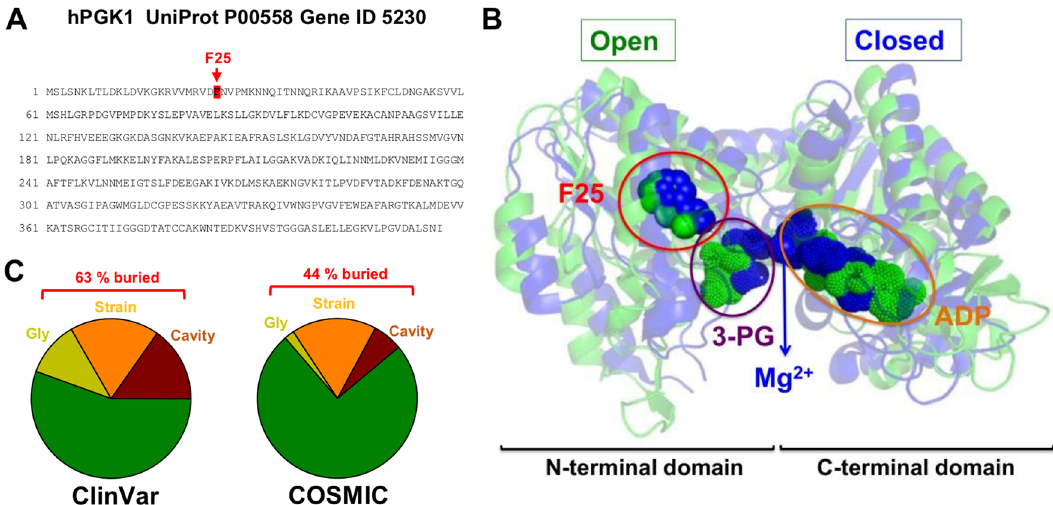
Figure 1. Location of F25 in the sequence and structure of hPGK1 and the biological significance of the mutations analyzed in this study. ( A ) Sequence of the hPGK1 protein (UniProt and Gene ID are indicated). The position of F25 is highlighted. ( B ) Structural location of F25 in two different conformations (open and closed) of hPGK1. The open conformation (PDB code 2XE7) is shown in green and closed conformation (PDB code 2X13) is shown in blue. These structures were reported in 14 . The location of 3-PG, ADP and Mg 2+ is also indicated as well the two domains of the protein. Please note that the conformational transition from open to closed conformation causes changes in F25 as well as in the ligands 3-PG and ADP. ( C ) Frequency of naturally- occurring mutations in hPGK1. Data were retrieved from ClinVar and COSMIC databases, and mutations were categorized in three meaningful sets: Cavity-making ( Cavity set, in dark red), Strain-inducing ( Strain set, orange) or Glycine-affecting ( Glycine set, dark yellow). The percentage of mutations belonging to either of these three sets which are buried in the structure is indicated in red. Details on the statistical classification and the identity of these mutations are found in Table